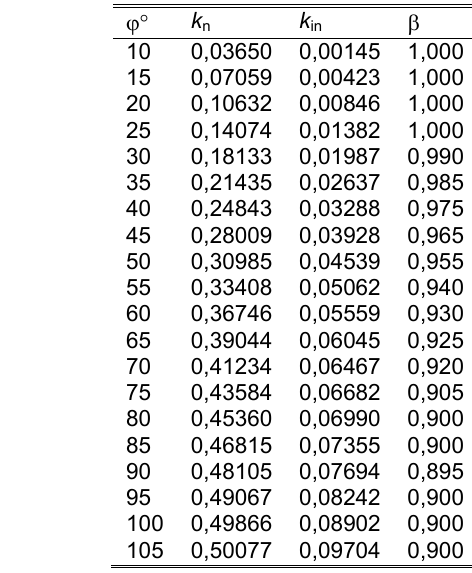
Normalizovani parametri PI regulatora, dobijeni primjenom metode max( J c ) za M s =2, na normalizovanom modelu (9) procesa sa ρ= 1 Normalized parameters of the PI controller, obtained by applying the normalized model (9) and the max( J c ) method for M s =2 and ρ=